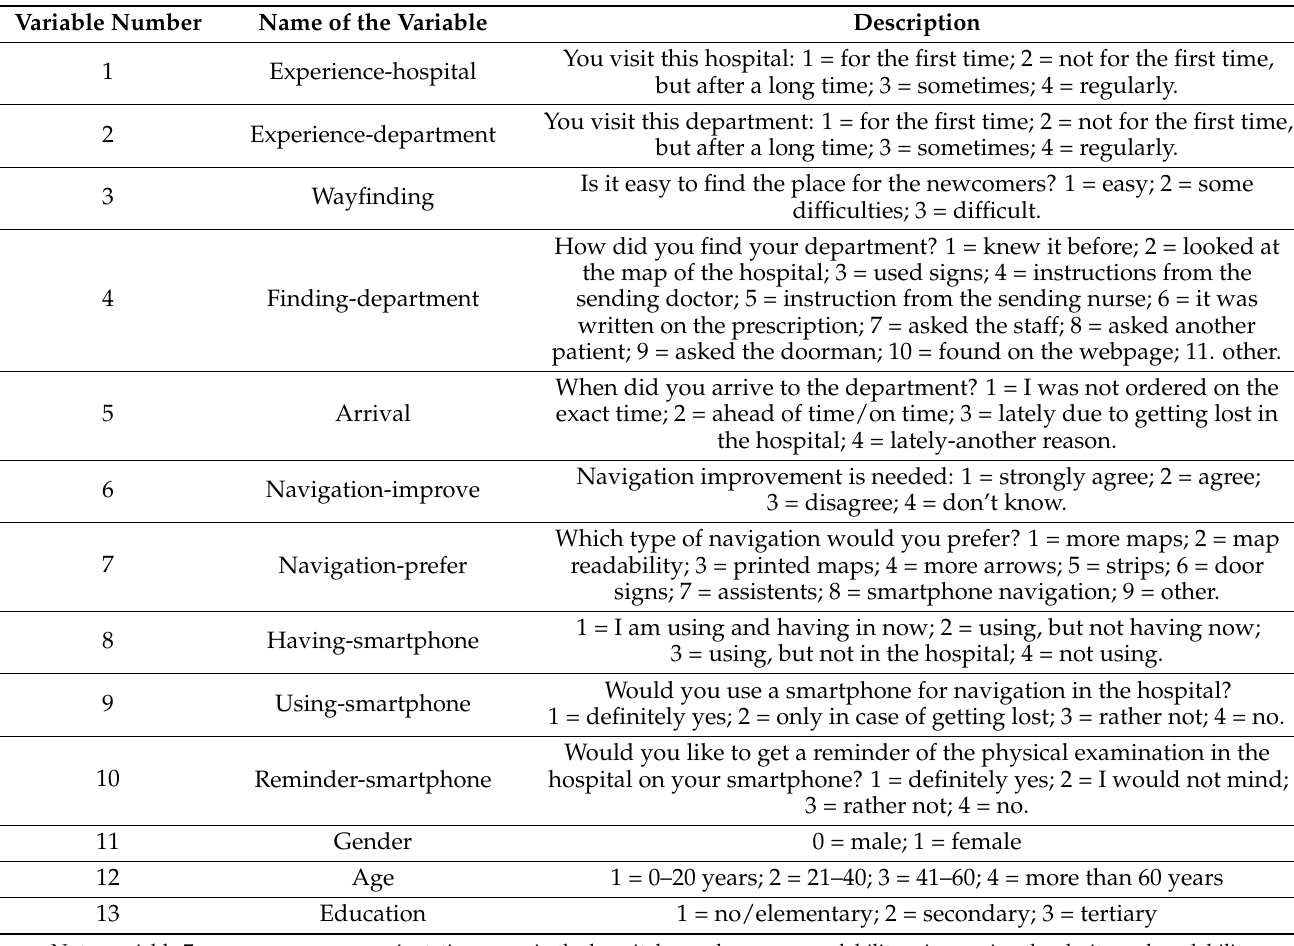
Table 1. Variables employed in the statistical